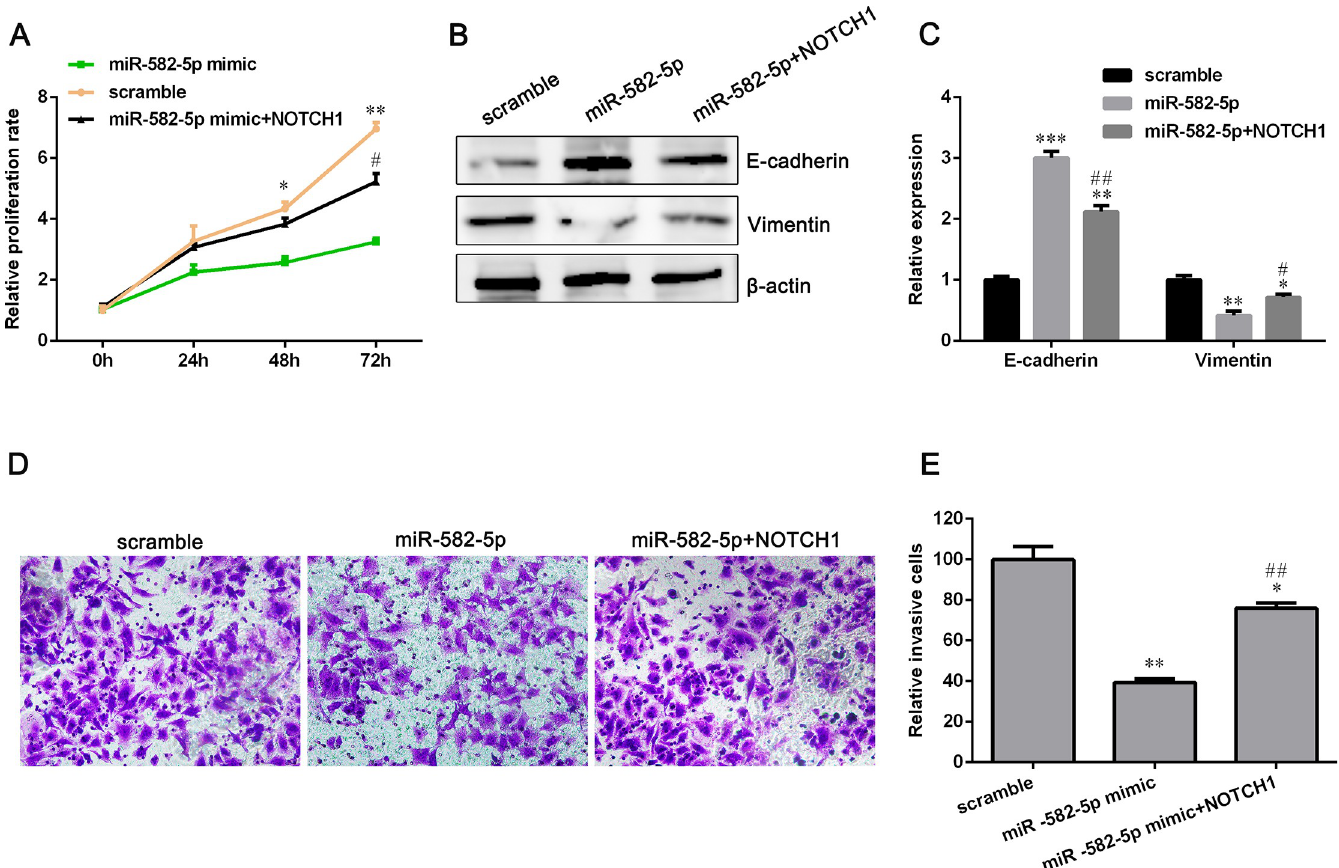
Fig 7. Overexpression of NOTCH1 rescues the miR-582-5p-mediated inhibition in NCI-H358 cell proliferation and invasion. (A) NCI-H358 cells were co- transfected with miR-582-5p mimics and NOTCH1 plasmids or vectors. And cell proliferation was assessed by CCK-8 assay. (B) Western blot assay was applied to examine EMT markers’ expression. (C) Relative protein expression of E-cadherin and Vimentin is shown. (D) Cell invasion was evaluated with Transwell assay. (E) Relative number of invaded cells is shown. Data are presented as mean ± SD (n = 3). � P < 0.05, �� P < 0.01 and ��� P < 0.001 versus the scramble group. # P < 0.05, ## P < 0.01 versus the miR-582-5p mimic